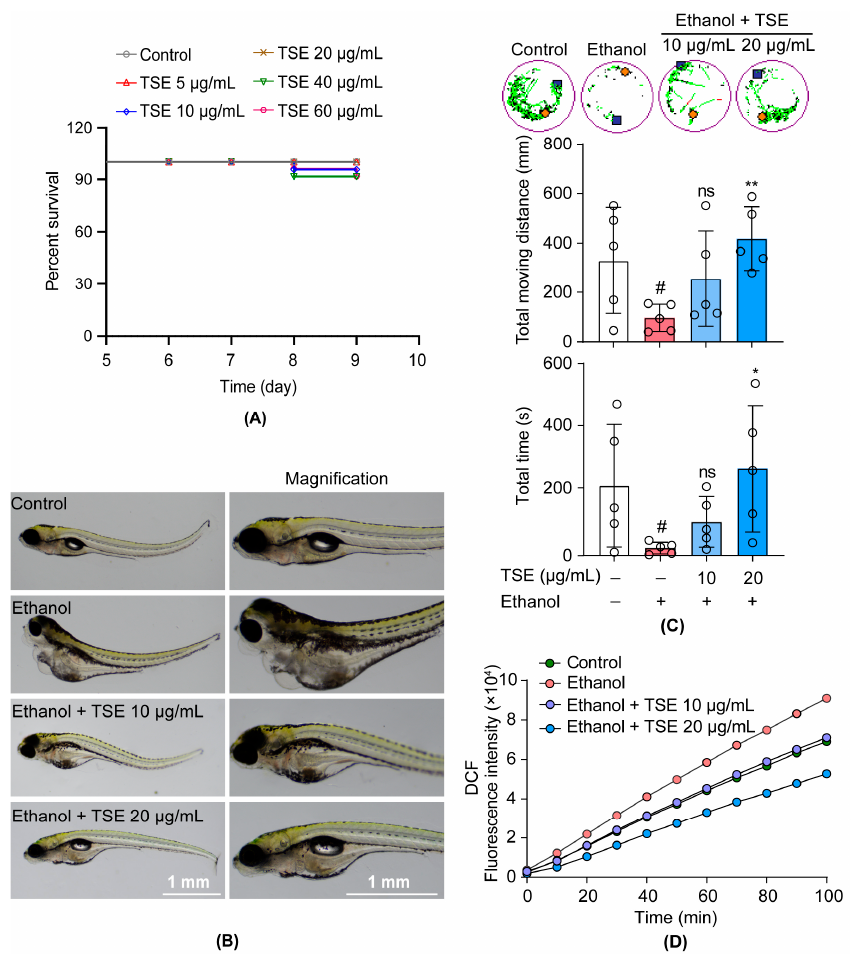
Figure 3. TSE ameliorated ethanol-induced behavior changes and oxidative stress in zebrafish. ( A ) TSE was used to treat 5 dpf zebrafish for 96 h to detect the toxicity of TSE. ( B ) TSE resisted ethanol-induced phenotypic changes in zebrafish, scale bar, 1 mm. ( C ) TSE ameliorated ethanol-induced behavior changes and increased the movement distance and activity time, n = 5 biologically independent samples. ( D ) The effect of TSE on the time-dependent changes of ethanol-induced DCF fluorescence intensity. Data represent the mean ± standard deviation and significant differences were analyzed by one-way ANOVA. # p < 0.05 vs. control group; * p < 0.05, ** p < 0.01 vs. ethanol group; ns, not significant vs. ethanol